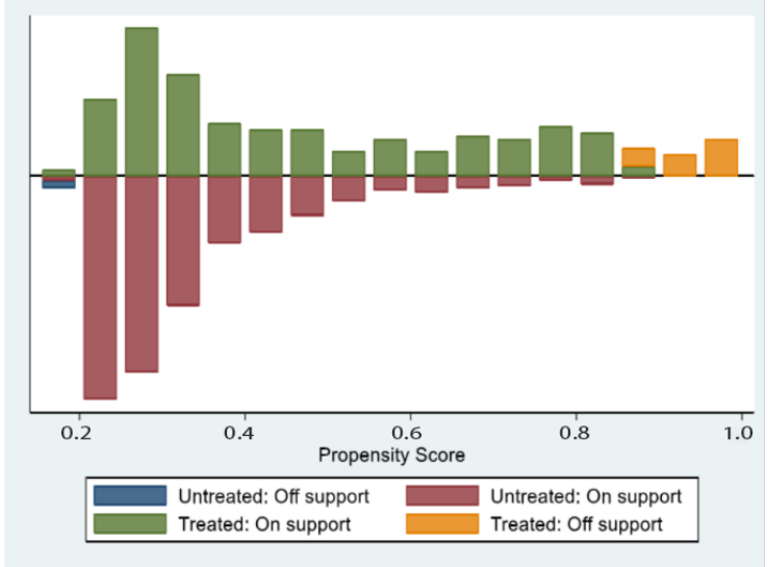
Figure 4. Common value range of covariates before and after matching.